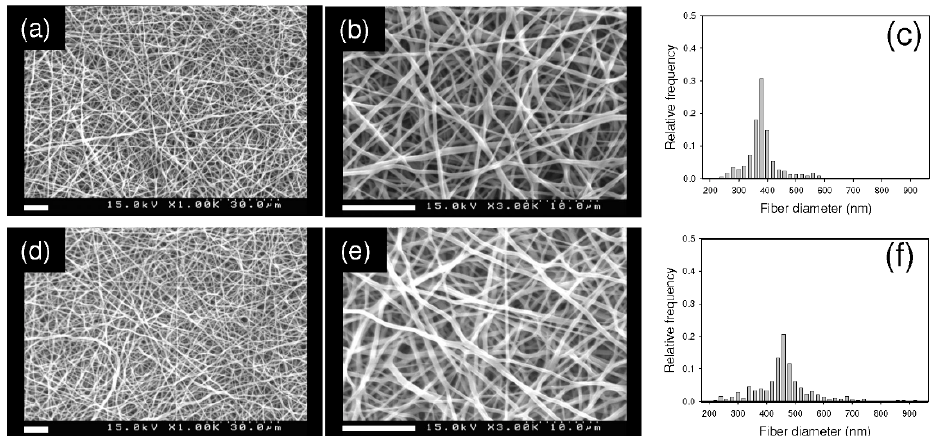
Figure 7. SEM images and diameter distributions of the as-spun PU-DMPA fibers ( a – c ) and the gelatin-modified PU-DMAP fibers ( d – f ); ( b , e ) are at higher magnifications. The scale bar at the bottom left of SEM images is 10 µm.